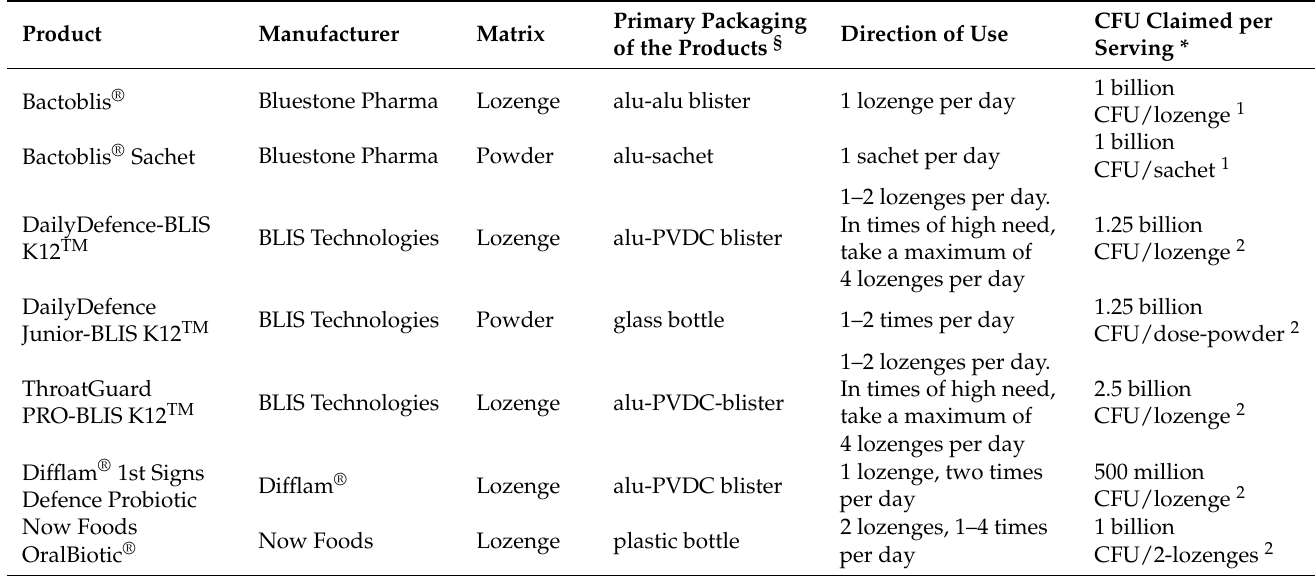
Table 1. Commercial probiotics containing SSK12 used in this